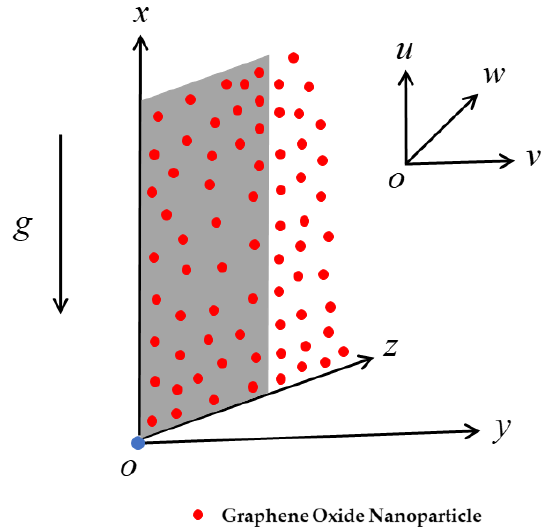
Figure 1. The configuration model for the nanofluid flow and embedded coordinate system.